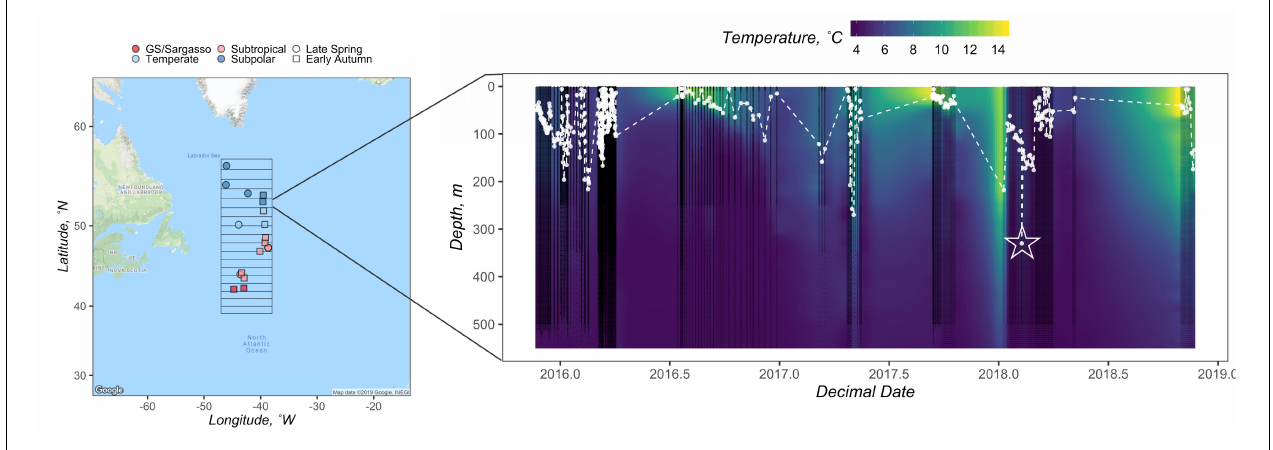
FIGURE 1 | Geographical map of the NAAMES study region (left), with station locations for the late spring and early autumn cruise designated as circles and squares, respectively. Stations are colored by subregional classification based on Della Penna and Gaube (2019). Gridded box displays the bounds of the in 1 ◦ latitudinal bins from which float data were available. Displayed on the right is an example composite of float data from the 52 ◦ latitudinal bin. Black points denote when water column data were collected by an ARGO float. The white points and dashed line mark the depth of the mixed layer ( n = 348). Z max MLD for this latitudinal bin was recorded as 330 m and is denoted by the star. Interpolated temperature data from the corresponding float profiles are shown in the background.